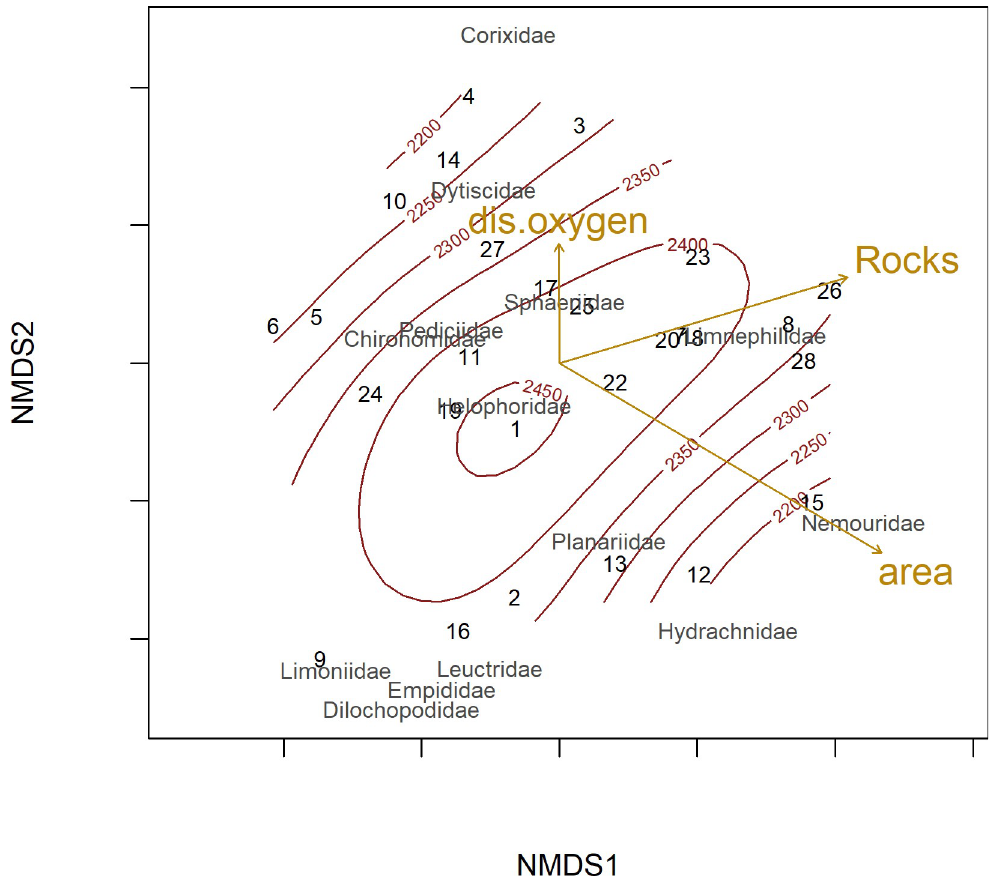
Fig 5. Non-metric multidimensional scaling (NMDS), illustrating similarity in macroinvertebrate community composition of alpine lakes. Dissolved oxygen (“dis.oxygen”), lake size (“area”) and share of rocky habitats (Rocks”) are shown as vectors, elevation shown as contour lines. Community composition was analysed on family level, the taxonomic groups “Hirundinea” and “Oligochaeta” were not included due to low taxonomic resolution. Permanova showed significance effects of elevation (R 2 = 0.07, P = 0.047), lake size (R 2 = 0.07, P = 0.040), rocky habitats (R 2 = 0.15, P = 0.001), dissolved oxygen (R 2 = 0.067, P = 0.049) and the interaction of elevation and lake size (R 2 = 0.11, P = 0.005) on community composition, see also Table